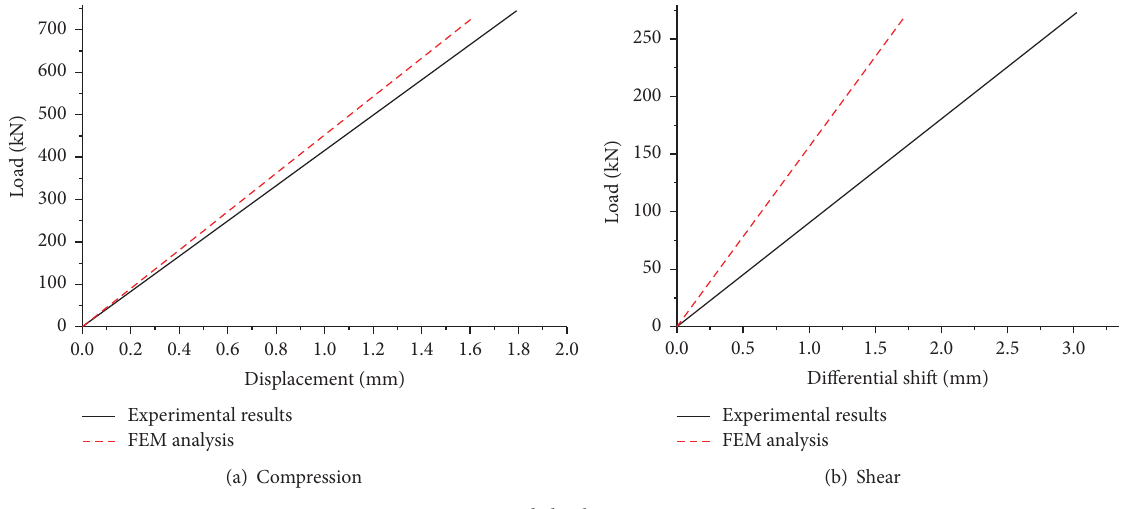
Figure 8: Load-displacement